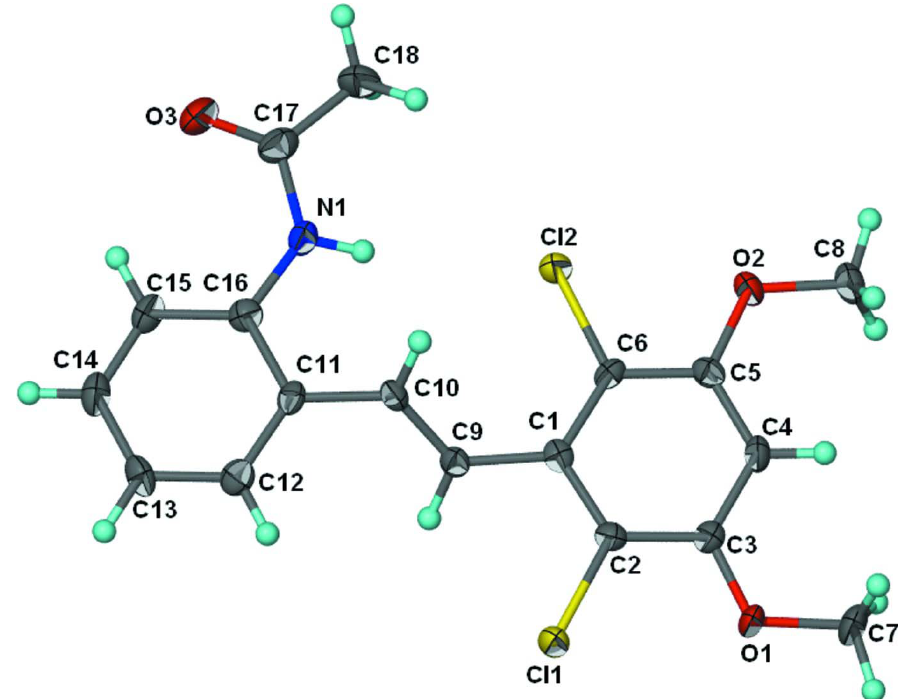
Thermal ellipsoid plot (Barbour, 2001) of C arbitrary